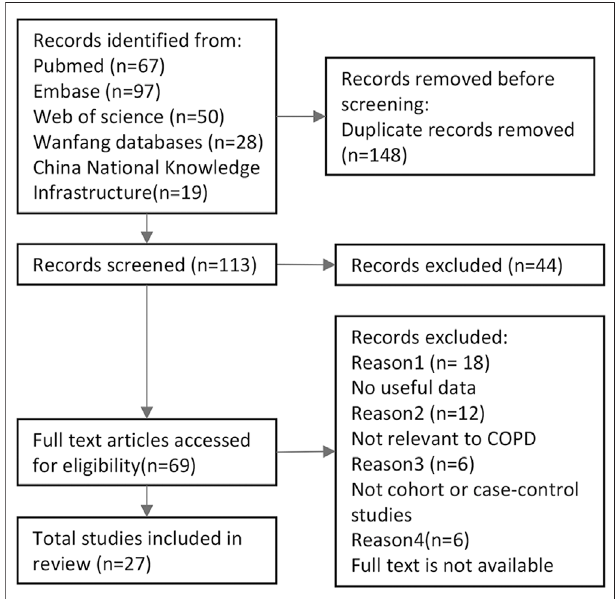
FIGURE 1 | Flowchart illustrating the search strategy for TNF- α polymorphism. and the risk of